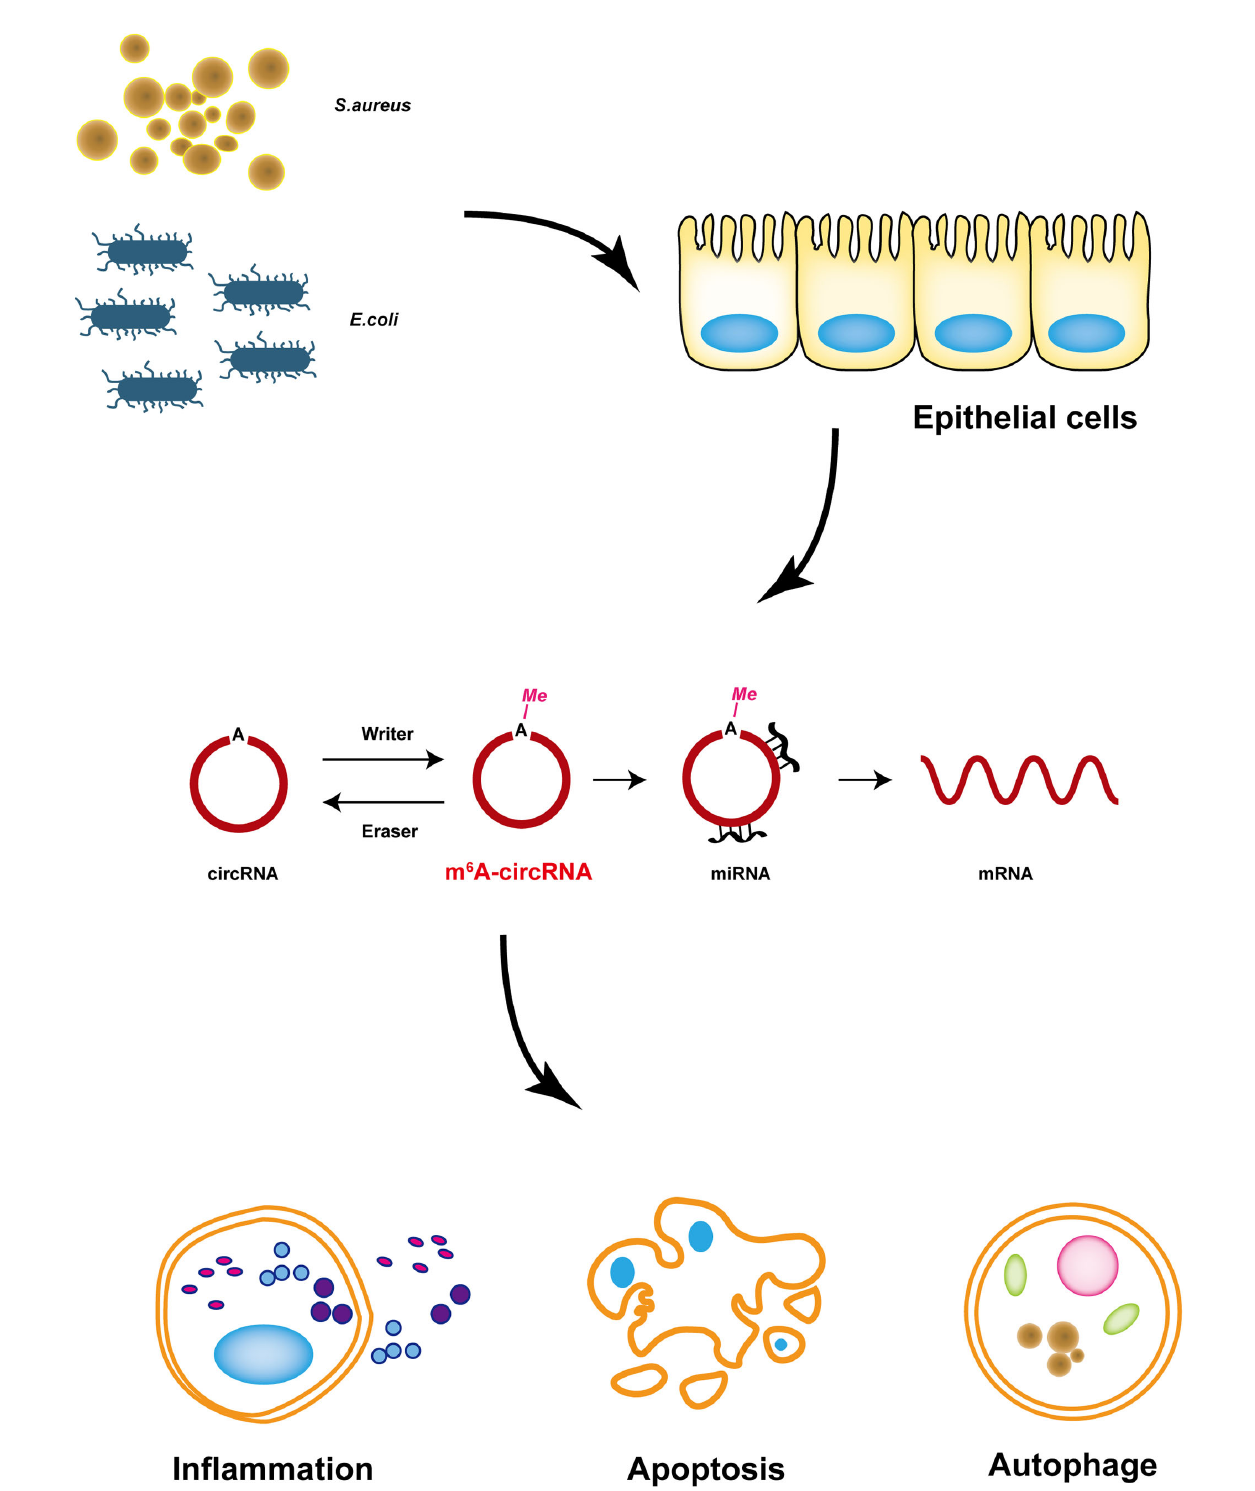
FIGURE 8 | Proposed model of m 6 A-modi fi ed circRNAs that regulate MAC-T cells injured by inactivated S. aureus and E. coli. m 6 A-modi fi ed circRNAs regulated MAC-T cell apoptosis, in fl ammation, and autophagy.